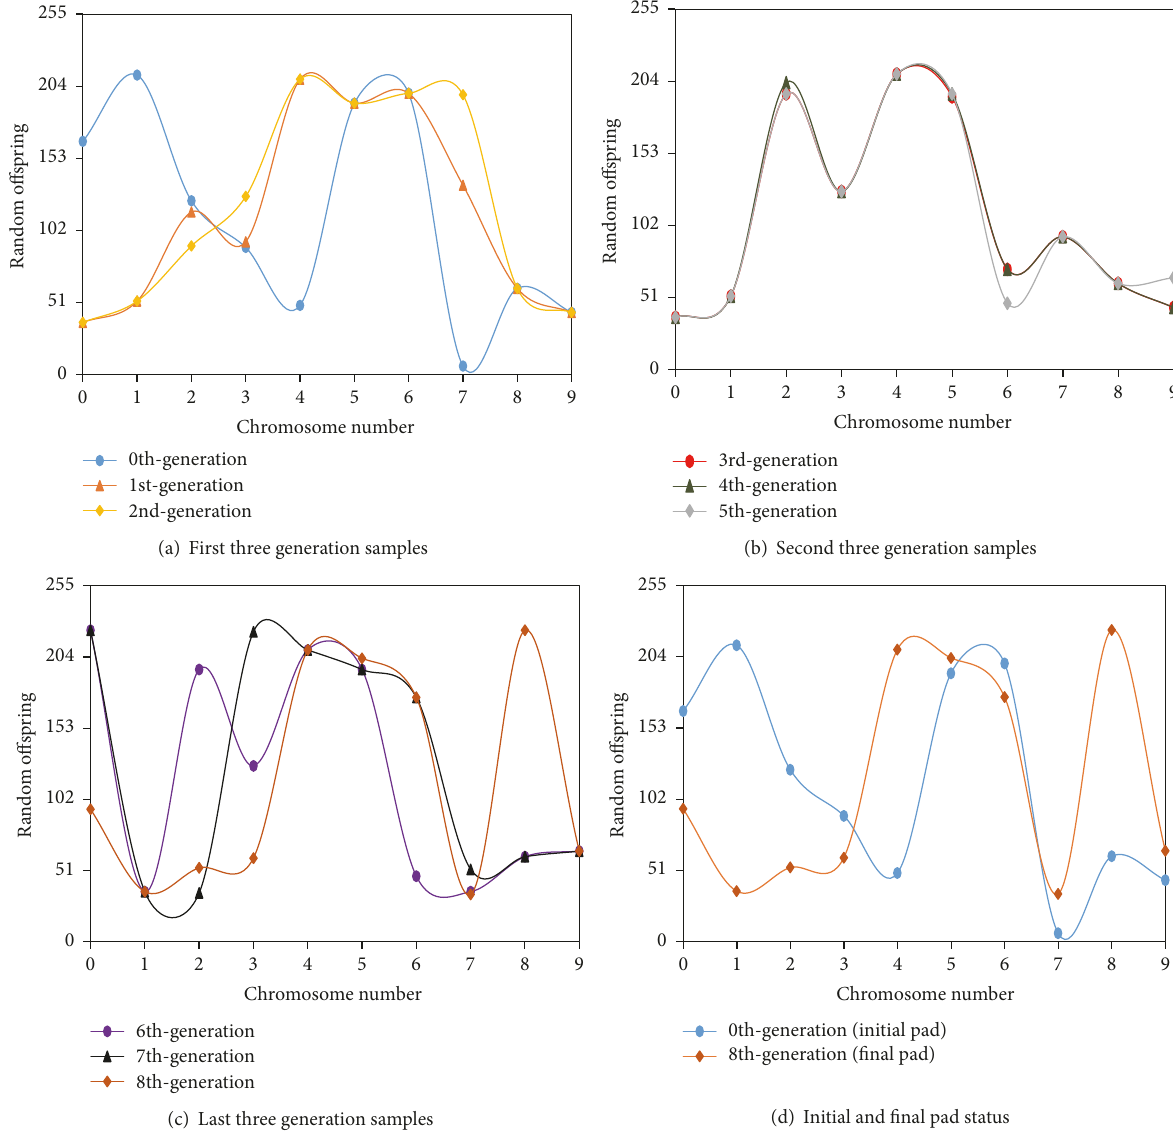
Figure 2: Changes in population with increase in generations ( 𝐿𝑒𝑎𝑠𝑡𝐺𝑒𝑛 = 10 , 𝑃 𝑐𝑚 = 0.2